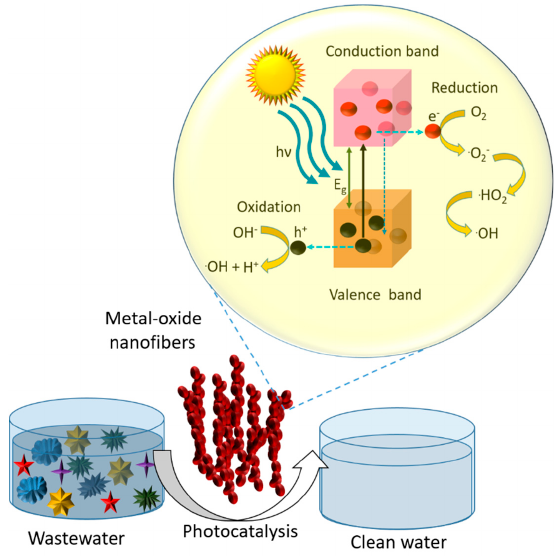
Figure 8. Schematic explanation of the metal oxide semiconductor nanofiber-mediated photocatalysis.